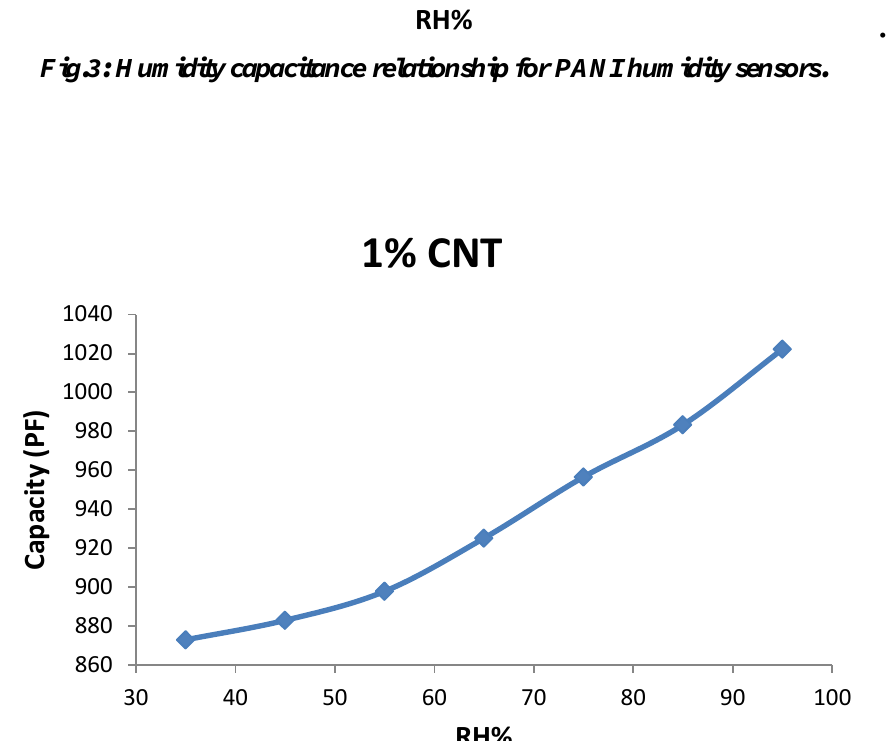
Fig.4: Humidity capacitance relationship for humidity sensors with 1%